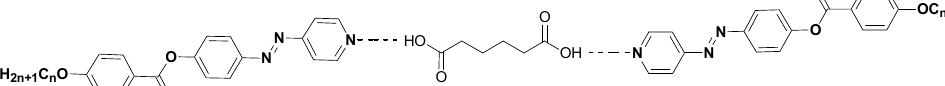
Figure 6. 1:2 HBSMCs A/2Cn [34].